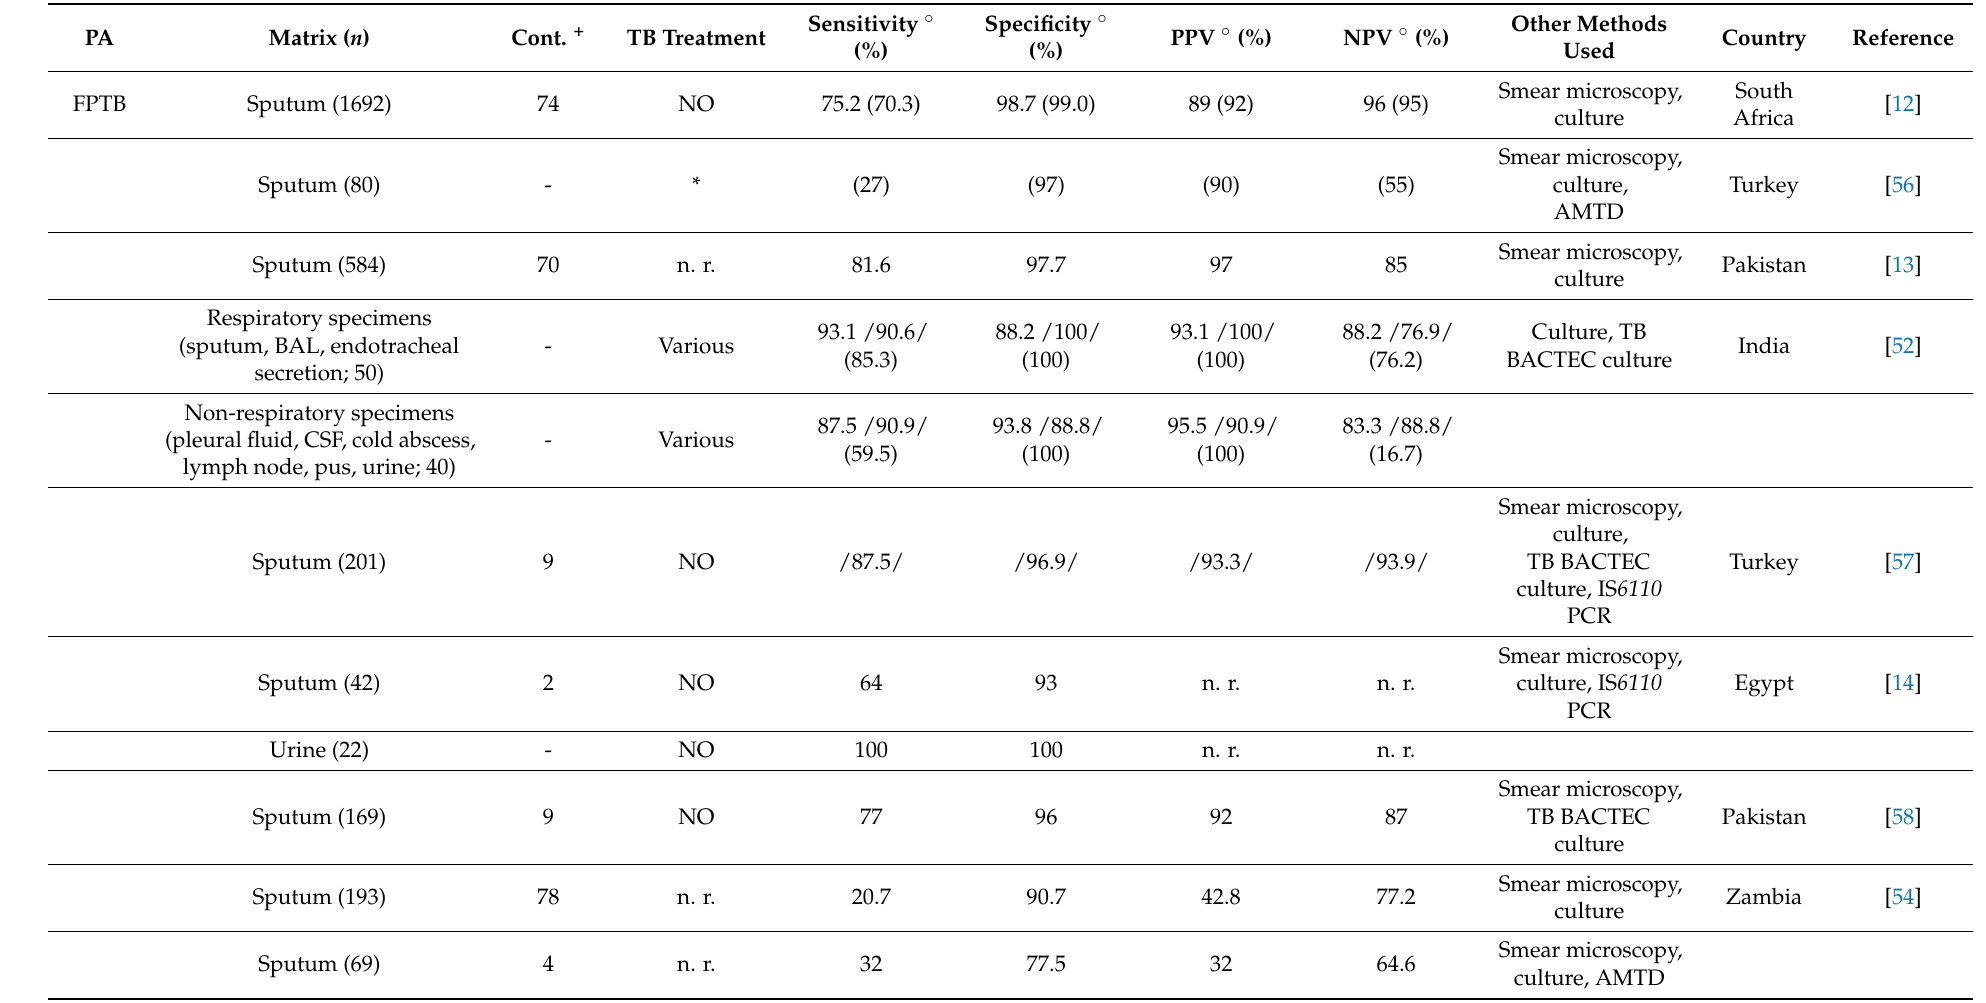
Table 2. Detection of M. tuberculosis complex bacteria in human clinical